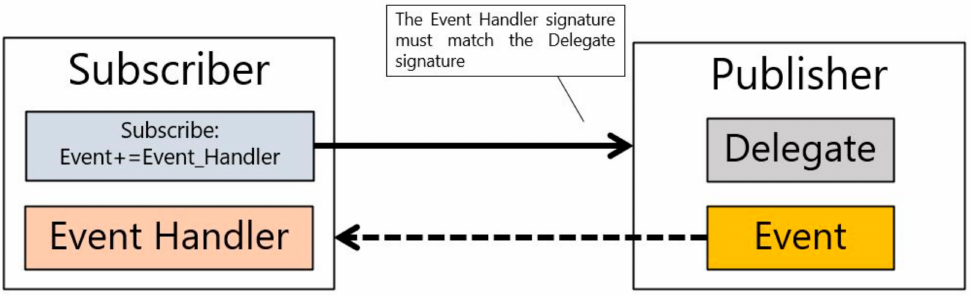
Figure 9. Publish–Subscribe pattern in